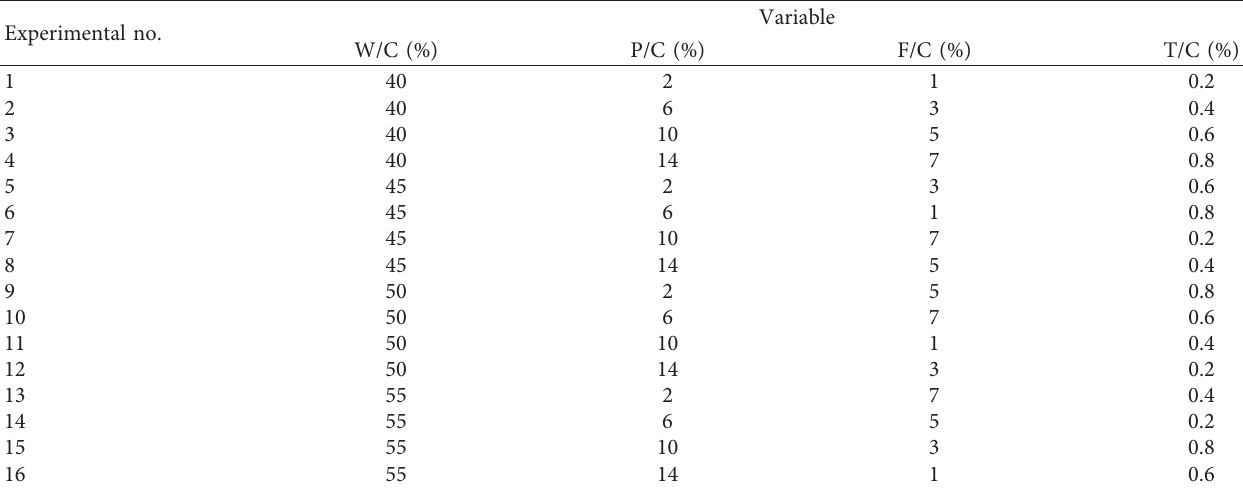
Table 8: Detailed ratio of each substance in the